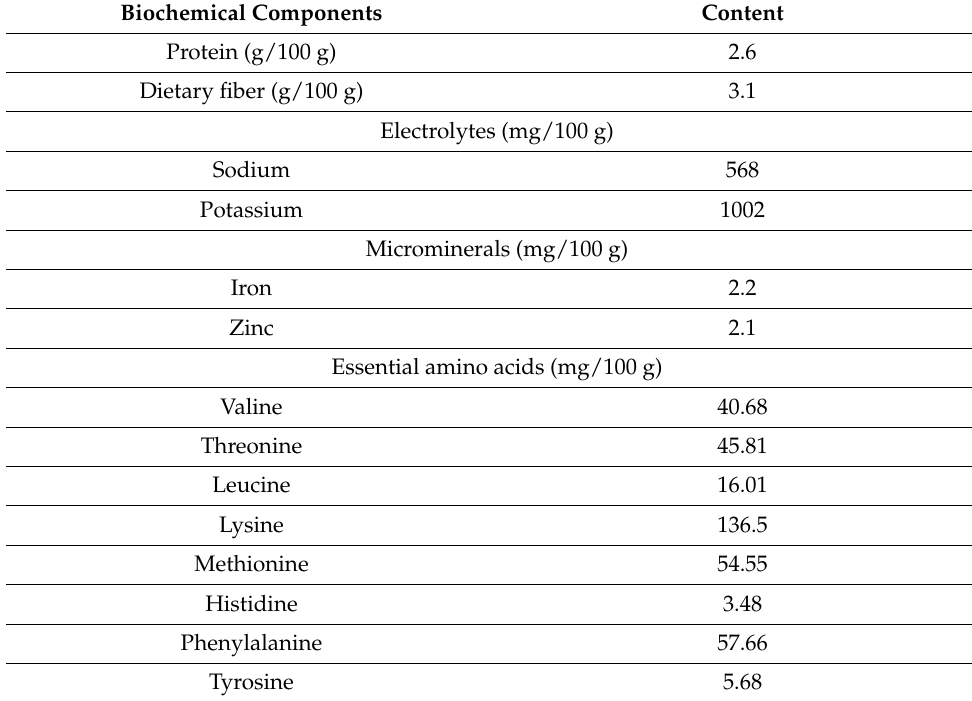
Table 8. Nutritional profile of coconut sugar made from inflorescence sap on a double-jacketed cooker and a modified conventional processing technique. (The results should be interpreted in light of the biochemical characteristics of coconut sugar, as listed in Tables 6 and